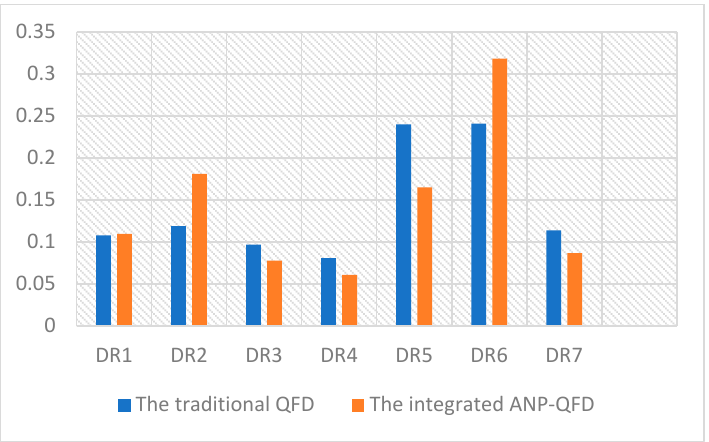
Figure 7. Relative weights of DRs in the traditional QFD and the integrated ANP ‐ QFD Table 12. Rankings of DRs in the traditional QFD and the integrated ANP ‐ QFD. Rankings The traditional QFD